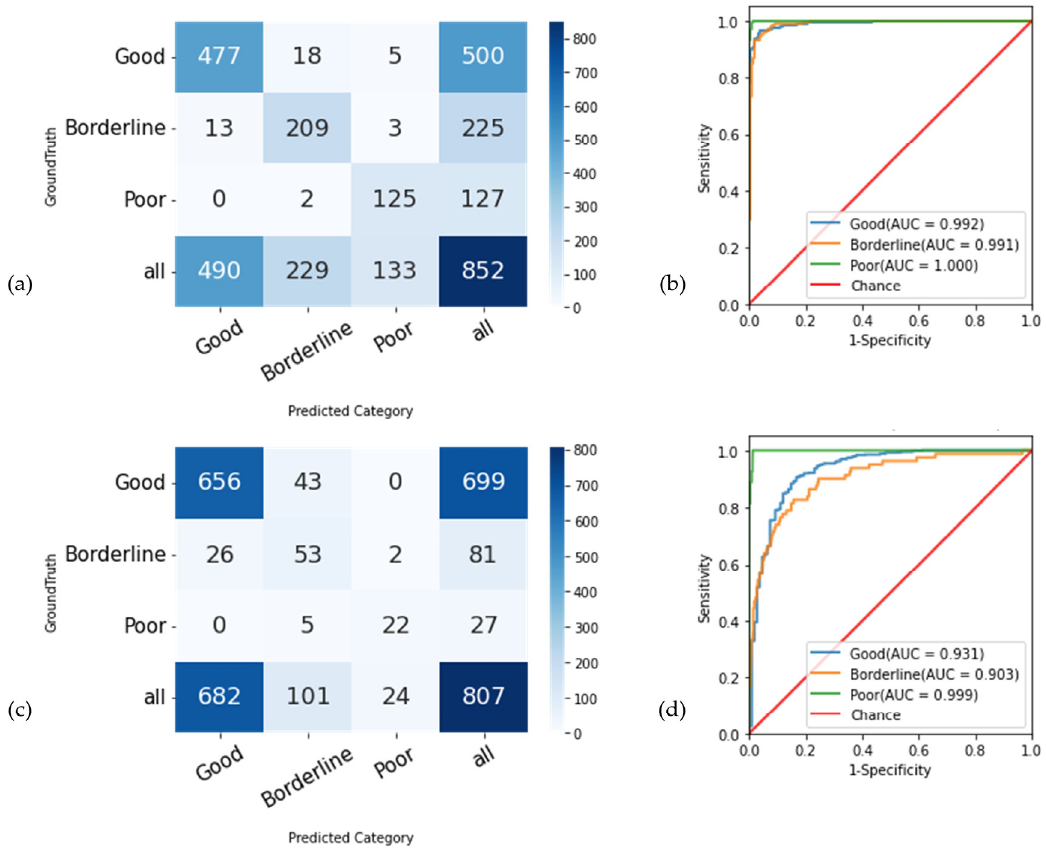
Figure 5. Confusion matrix plot and ROC curve of image quality task on internal-testing and external-testing datasets. ( a ): confusion matrix of the internal-testing dataset; ( b ): ROC curve of the internal-testing dataset; ( c ): confusion matrix of the external-testing dataset; ( d ): ROC curve of the external-testing